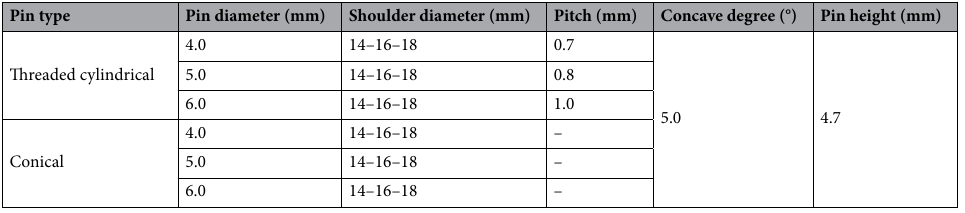
Table 4. The characteristics of the tools.